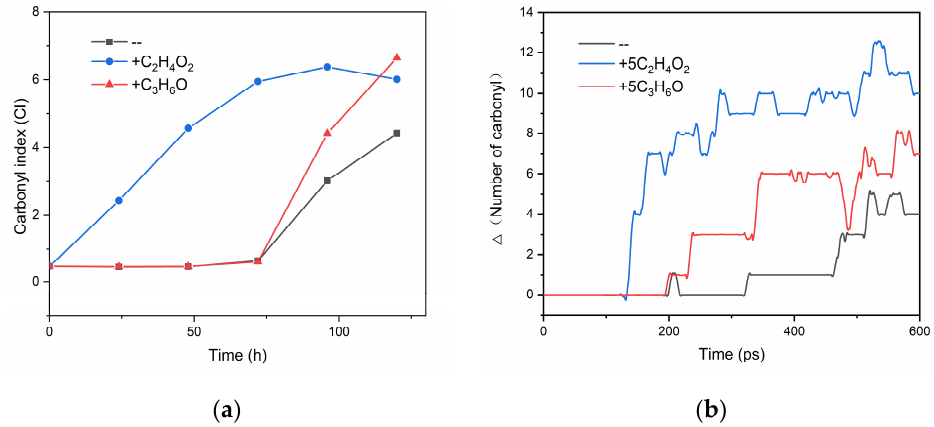
Figure 8. ( a ) The experimental results according to Reference [16]; ( b ) The reactive molecular dynamics (RMD) simulation result: evolution of the change of carbonyl number with time when the number of acetic acid/acetone added to the model is five (since acetic acid and acetone contained carbonyl groups, the number of carbonyls counted here should subtract the initial carbonyl number in the model for a more reasonable